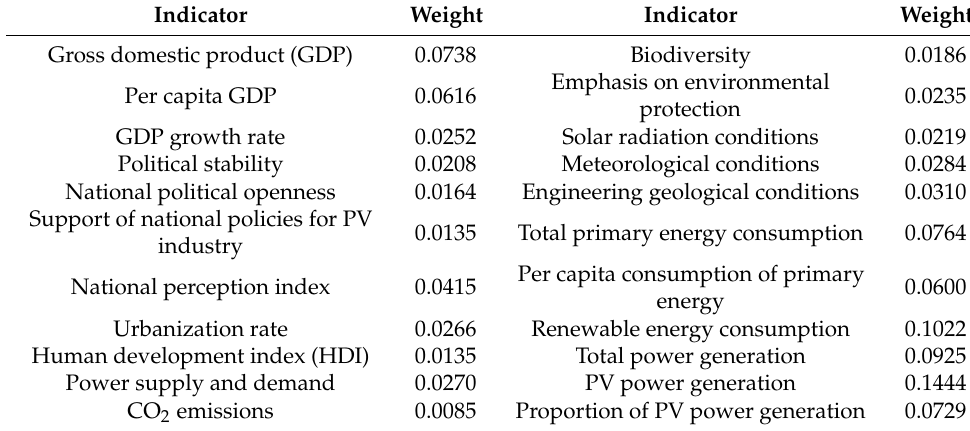
Table 5. Indicator